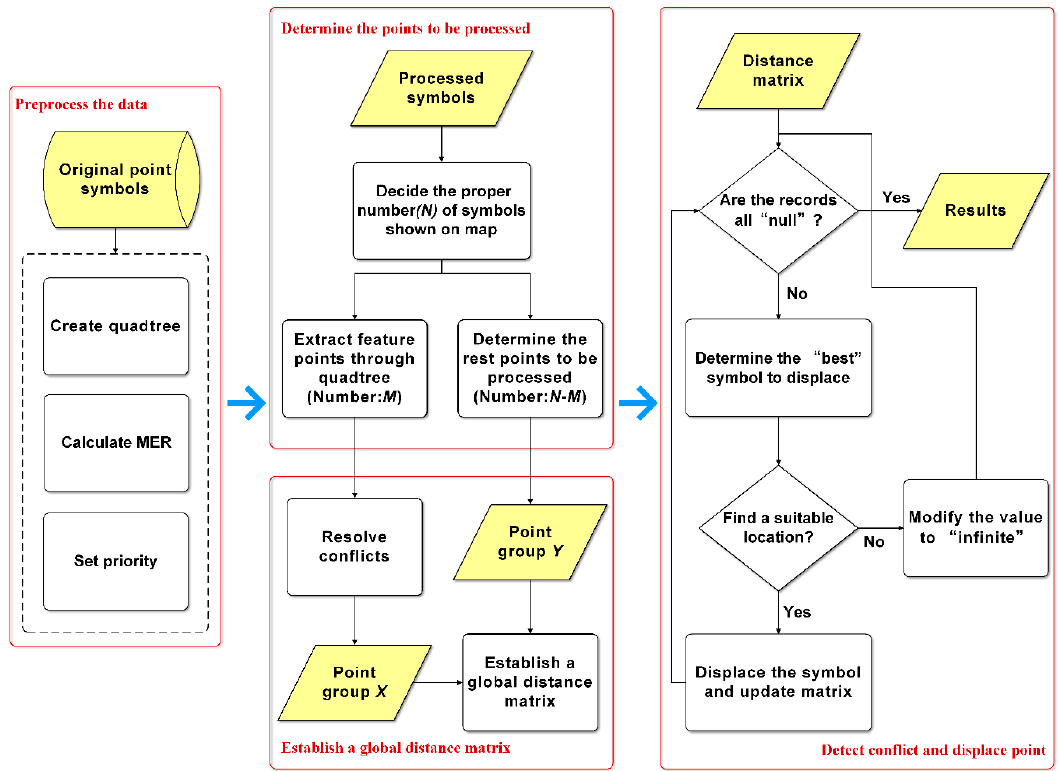
Figure 3. Overall flowchart of the algorithm. Four main steps are shown in the red box and arrows indicate the order in process.